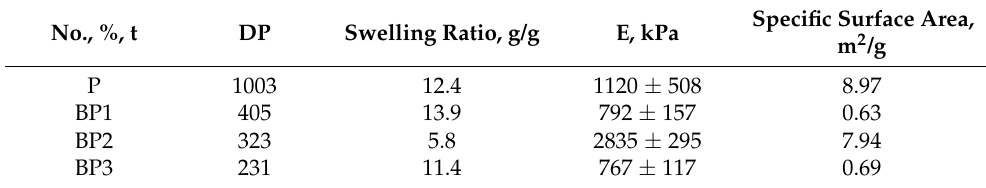
Table 2. The properties of cryogels obtained from biomodified pulp of different conversion levels. No., %,